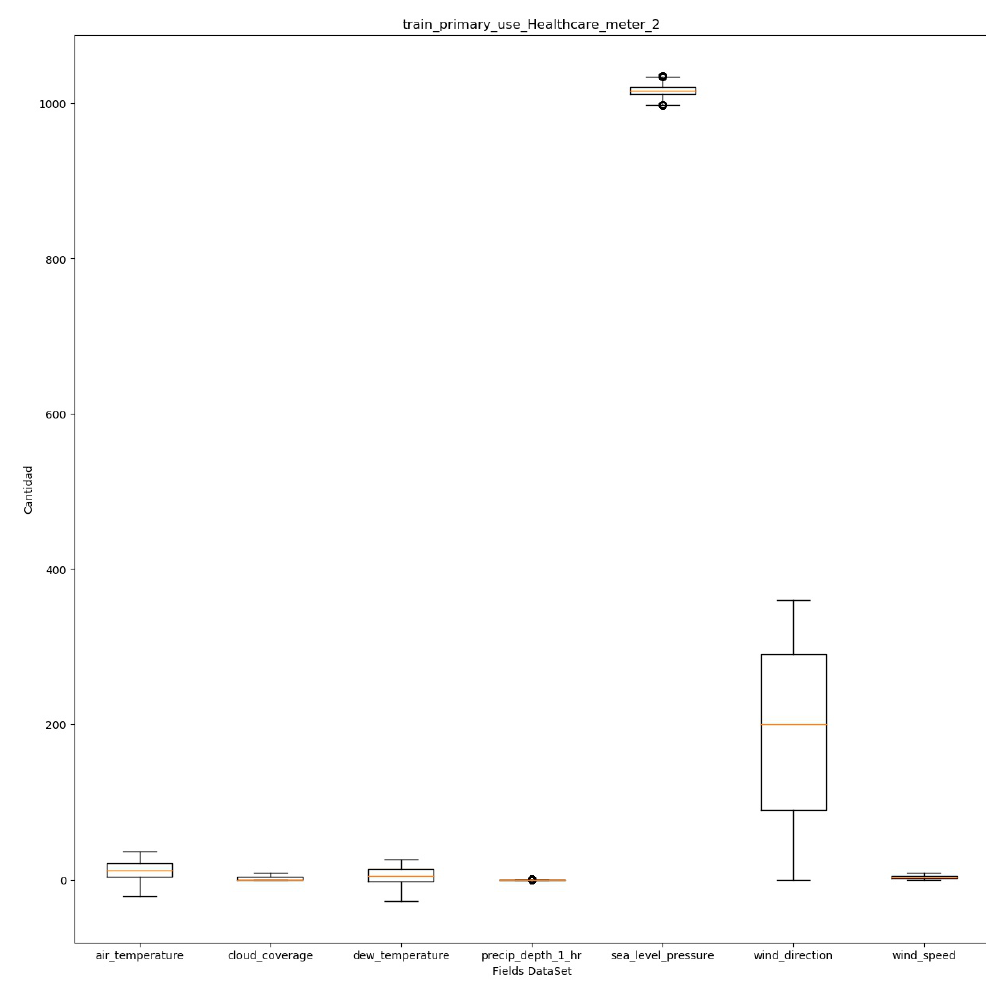
Figure 9. Outliers